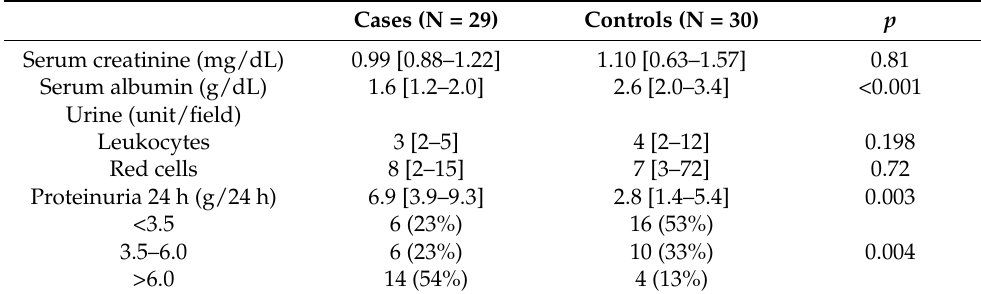
Table 1. Laboratory data at the time of renal biopsy. Cases (N = 29) Controls (N = 30) p Serum creatinine (mg/dL) 0.99 [0.88–1.22] Serum albumin (g/dL)